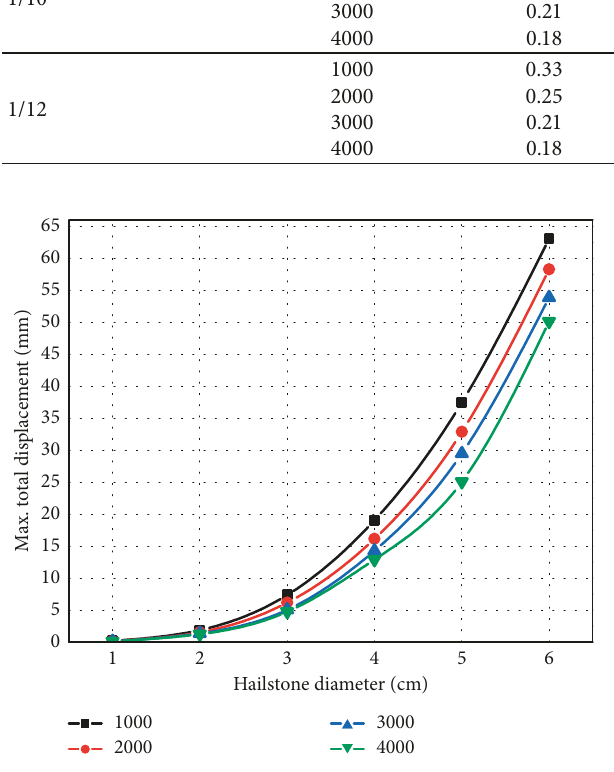
Figure 8: Max. total displacement curves of the impact point when arch-to-span ratio is 1/10 and the pretension levels increase from 1000 to 4000N/m.